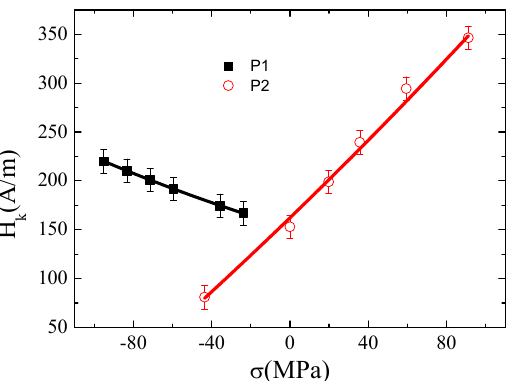
Figure 5. Evolution of anisotropy field, H k , with applied mechanical stresses, σ , for the studied samples. The second-order fitting curve is also shown.